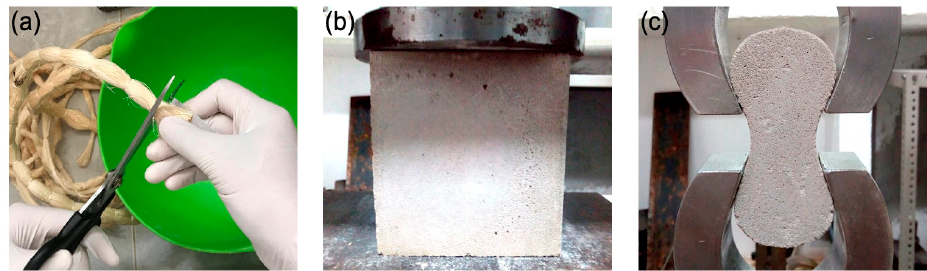
Figure 1. ( a ) Henequen fibers; ( b ) compression test set-up; and ( c ) tension test set-up.